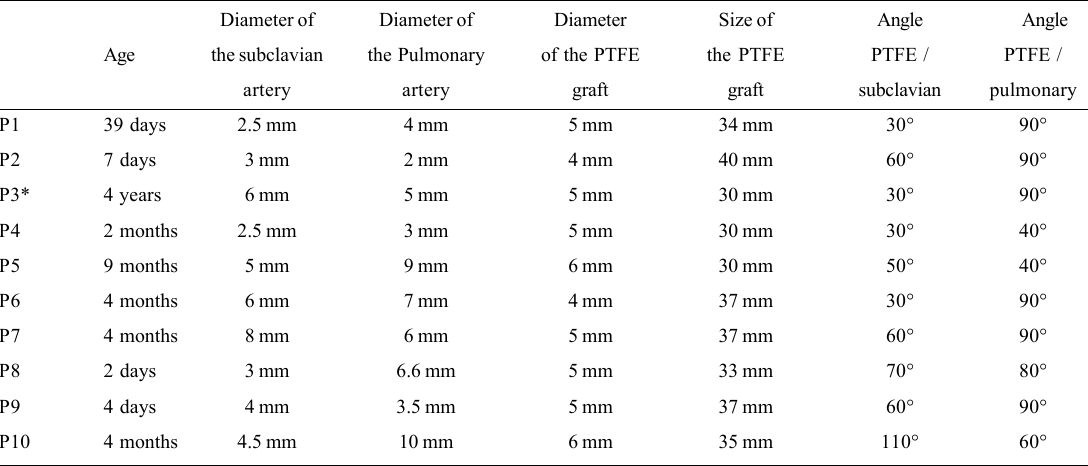
Table 1. Characteristics of patietns with cyanotic congenital heart diseases whose modified Blalock-Taussig surgery served as a model for this study.